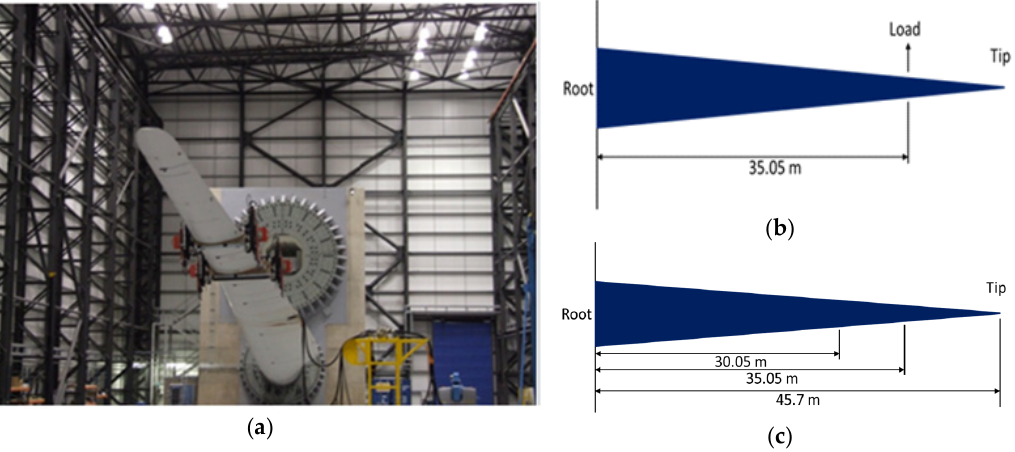
Figure 3. ( a ) 47.5 m blade attached to Hub Centre 1; ( b ) position of applied load point in